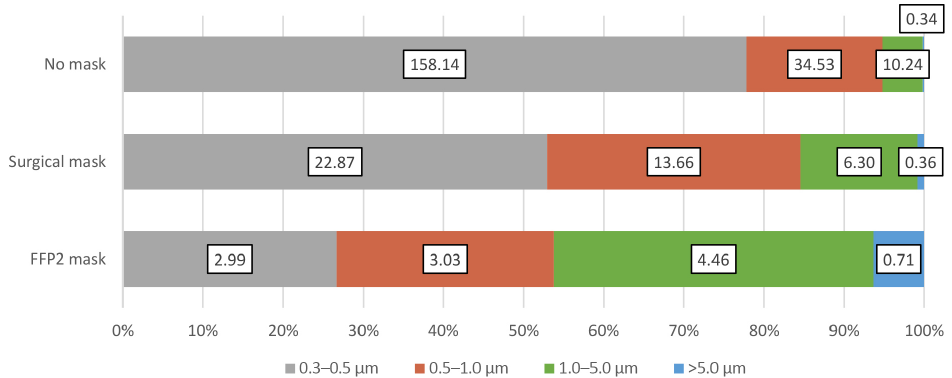
Figure A1. The mean particle emission rate [particles/s] and the mean size distributions of the emitted particles from all test subjects when wearing no mask, surgical mask, and FFP2 mask.